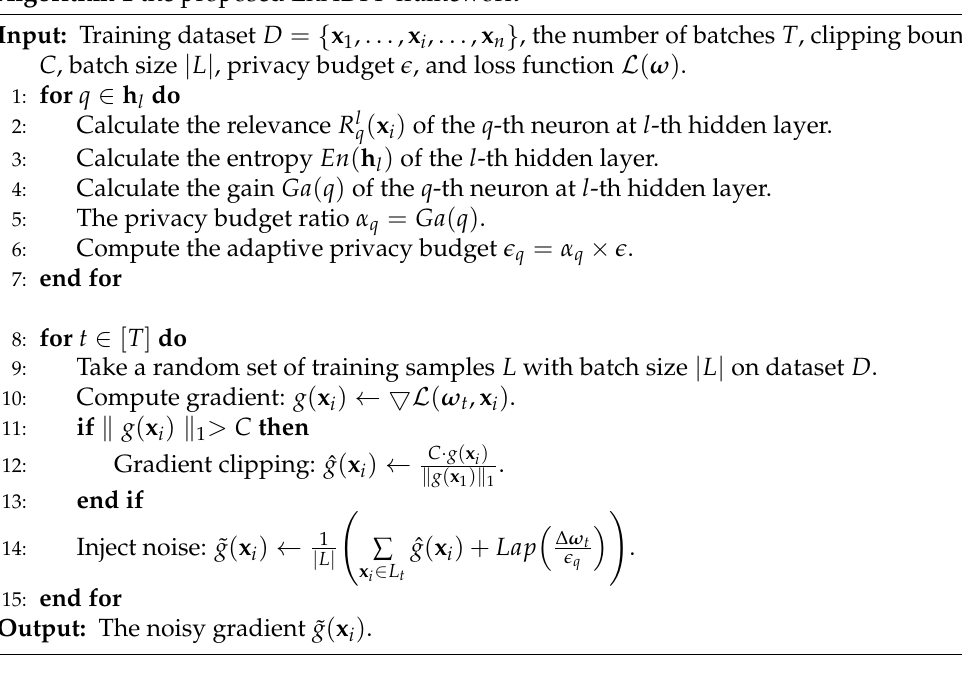
Algorithm 1 the proposed EnADPP